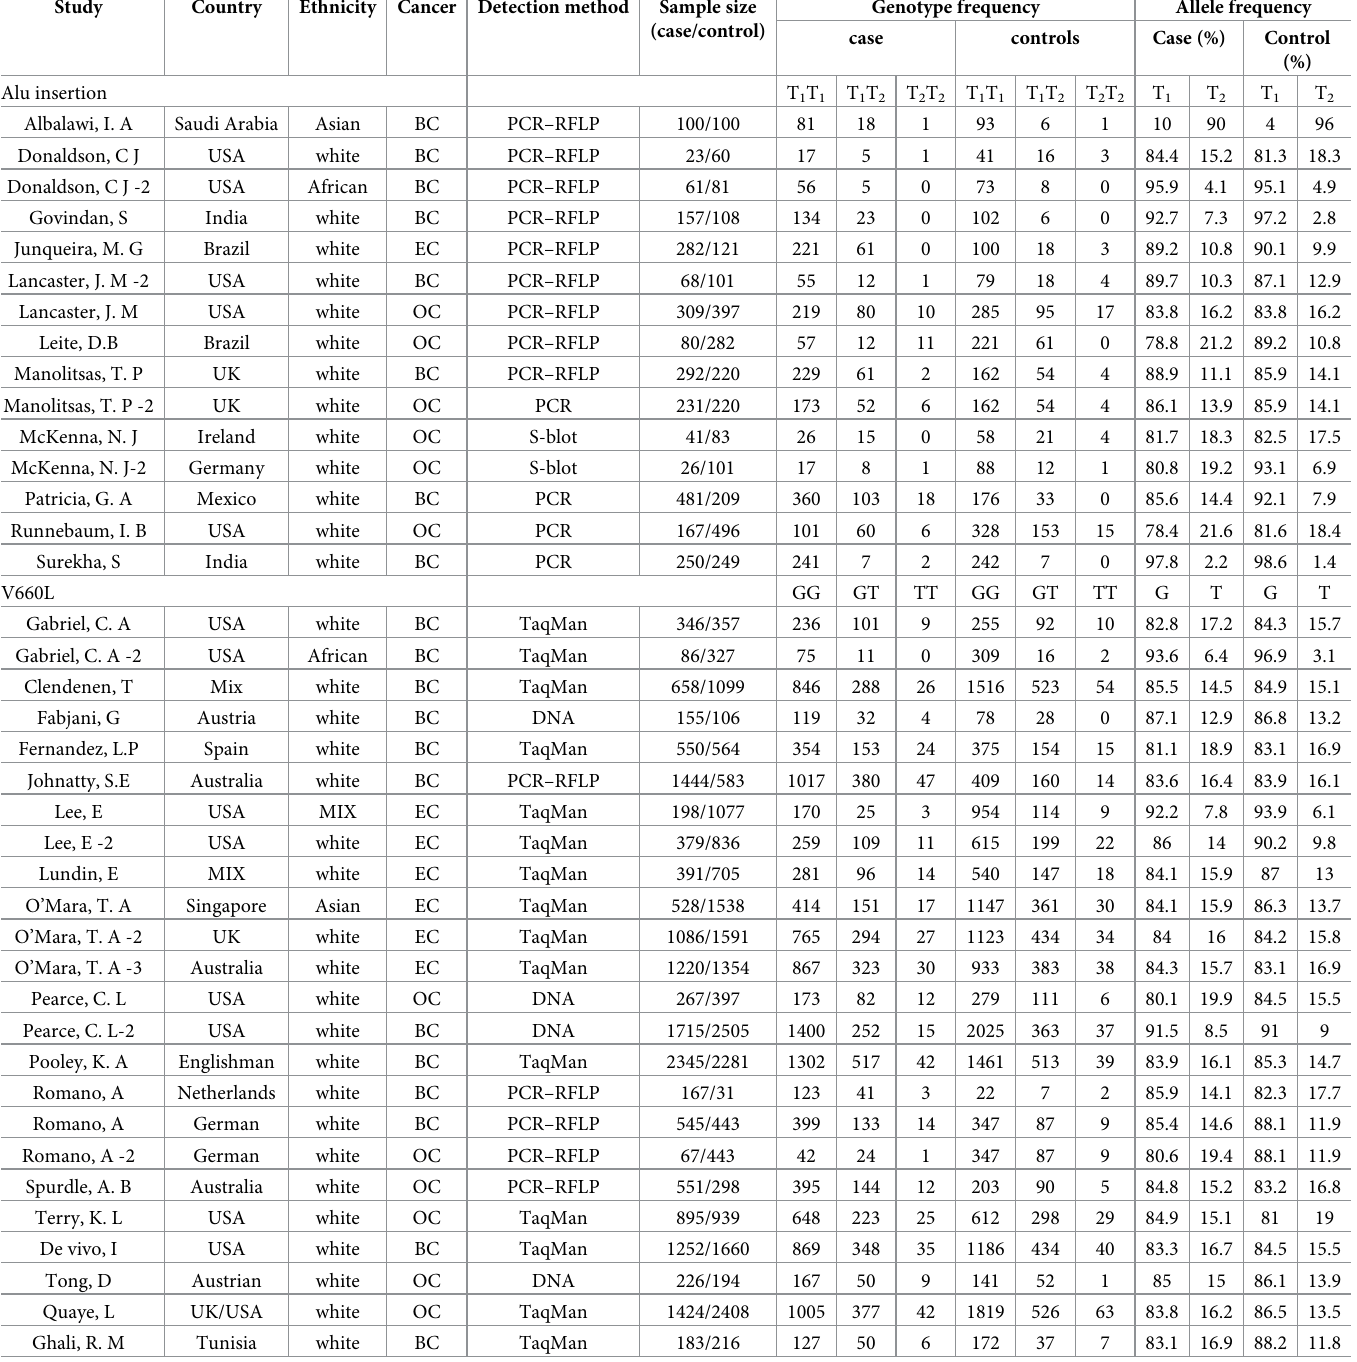
Table 1. Characteristics of the studies included in the